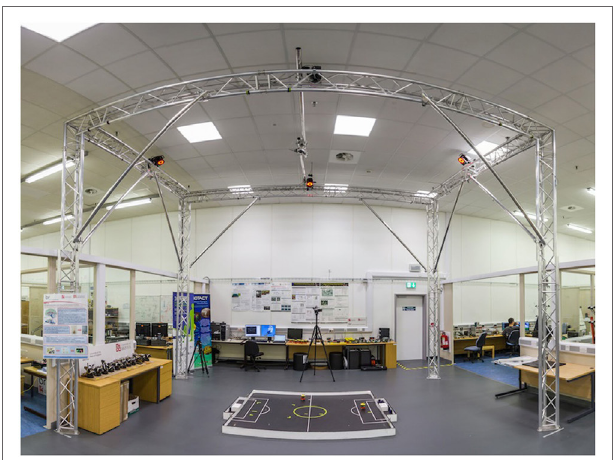
FigUre 9 | Experimental infrastructure showing the arena on the bottom, the camera used to document the experiments, and the Vicon motion capturing system overhead.